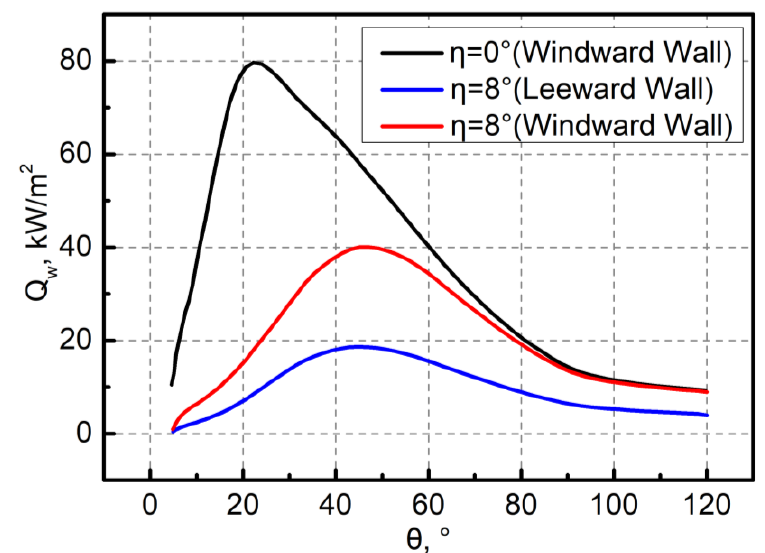
Figure 8. Comparison of heat flux distribution of nose cone.